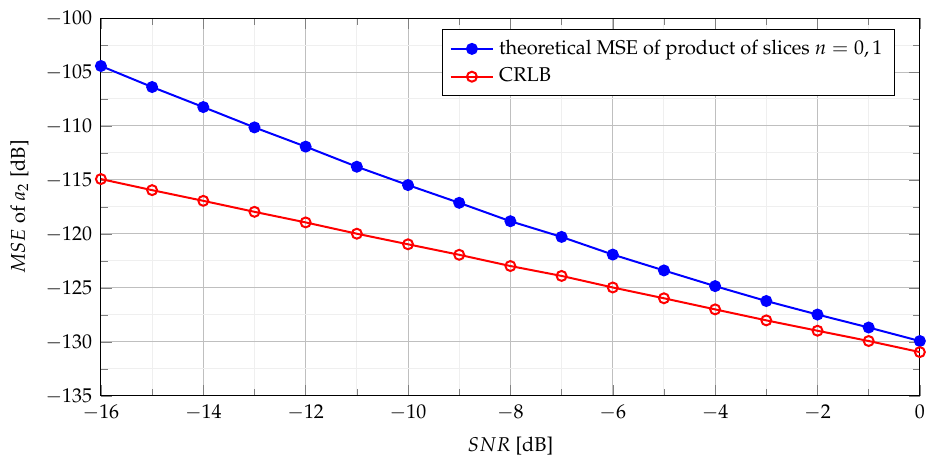
0,1 . Figure 3. Theoretical MSE of product of slices n = 0,1 . 0,1 . { } { } { }